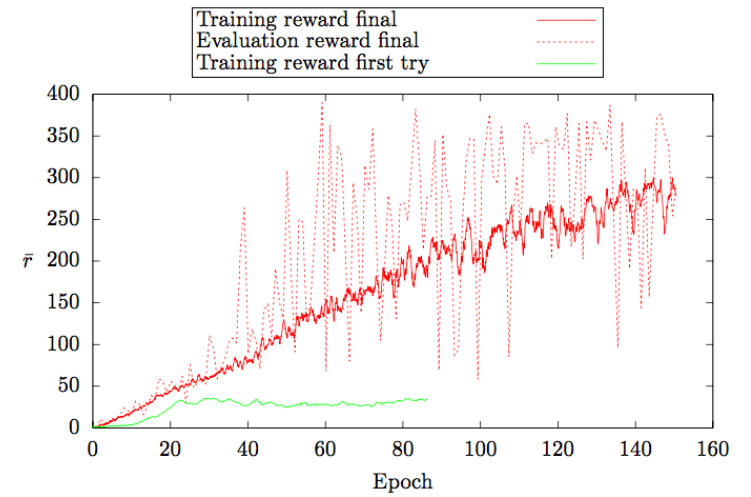
Figure 24. DDQN hyper-parameter attributes: average reward